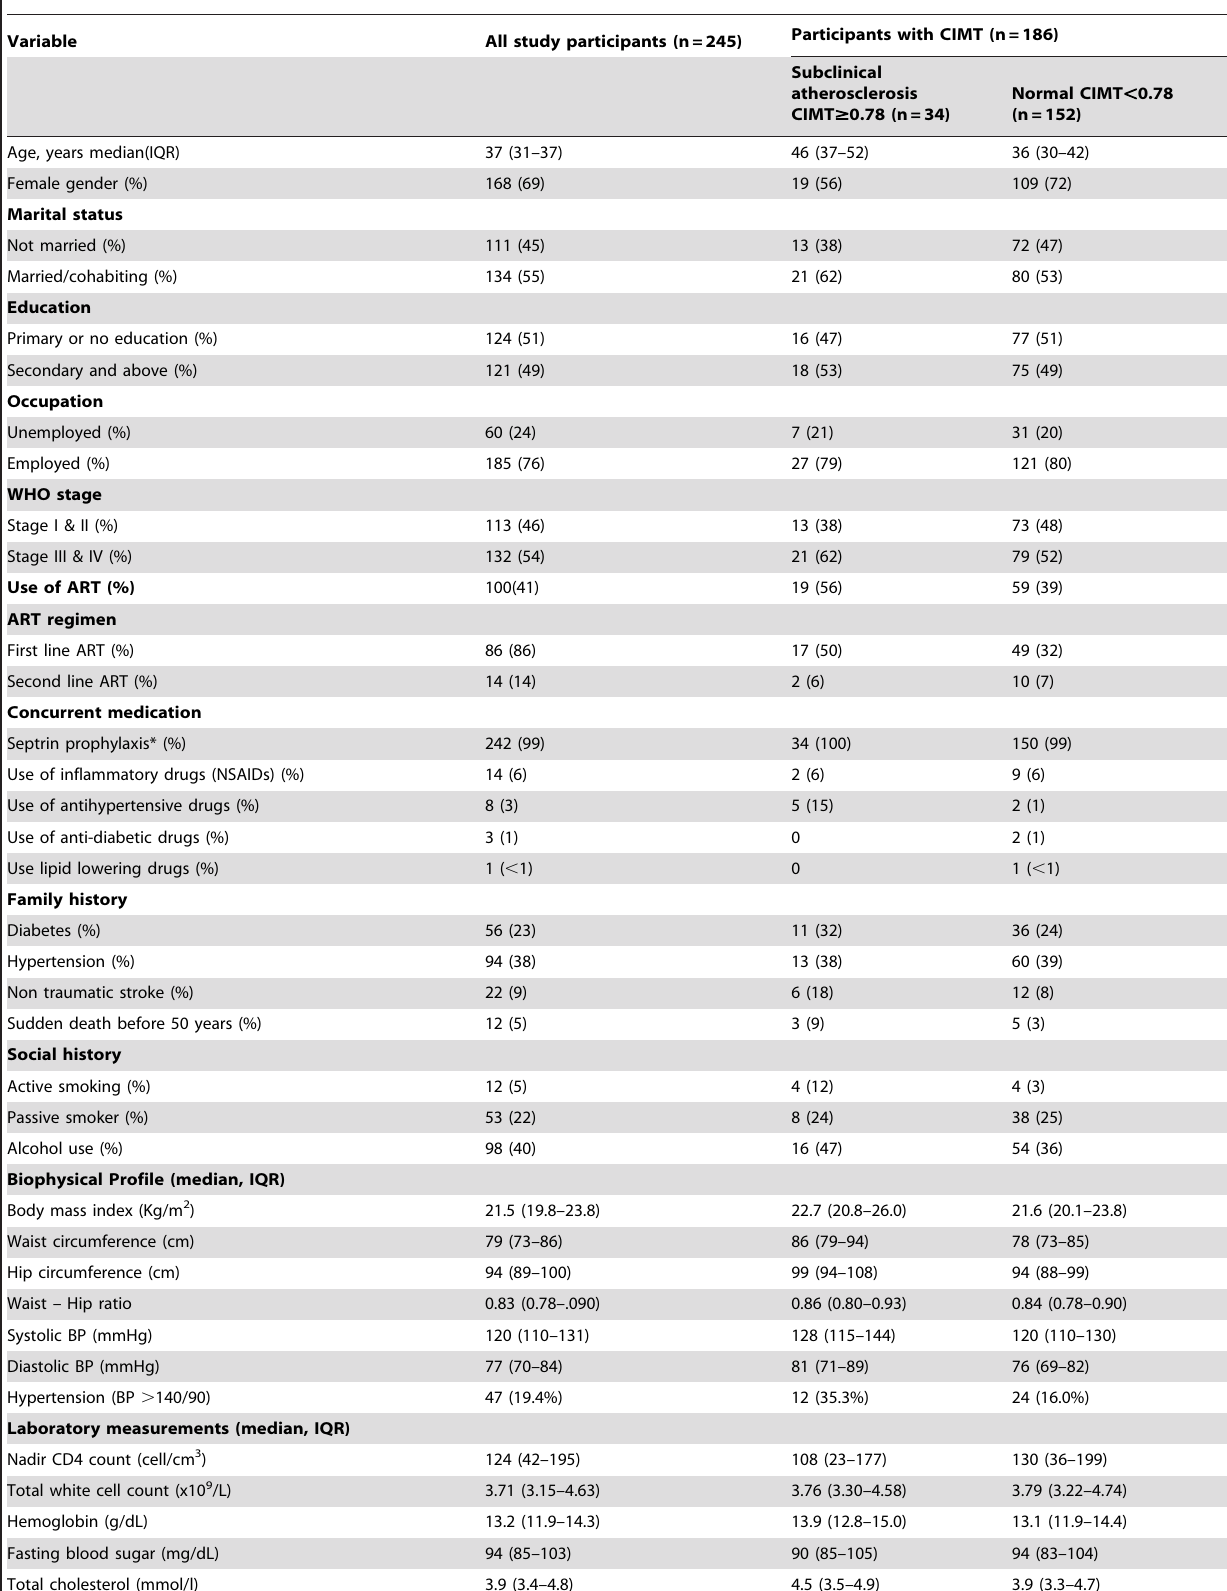
Table 1. Characteristics of HIV infected adults attending two large ambulatory HIV clinics in